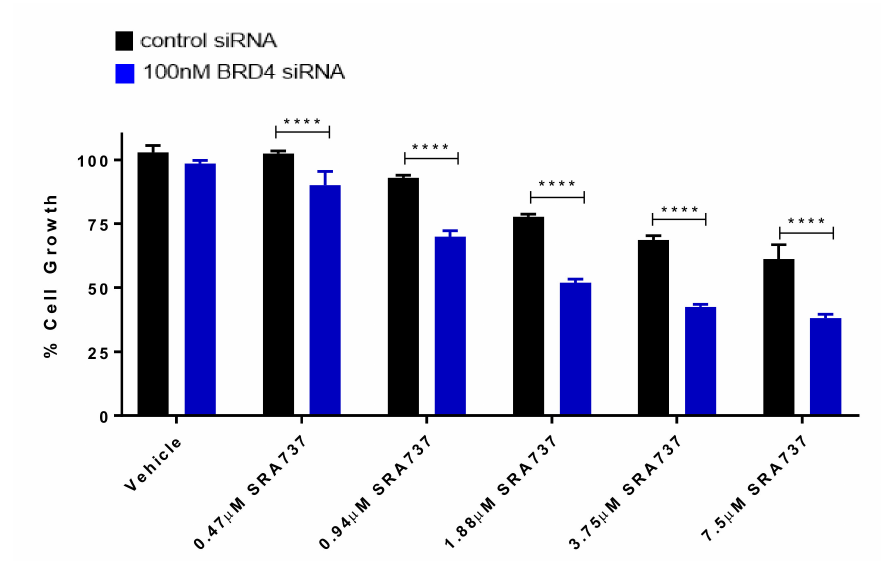
Figure 7. BRD4 knockdown enhances CHK1i / SRA737-mediated growth inhibition. Following transfection for 24 h (control siRNA or 100 nM BRD4 siRNA pools), Saos2 cells were treated with CHK1i / SRA737 for 5 days and cell growth was evaluated by methylene blue staining. One-way ANOVA followed by a Holm–Sidak post-hoc pairwise multiple comparisons test, n = 3; **** p < 0.0001 vs. control siRNA. Data are representative of two independent